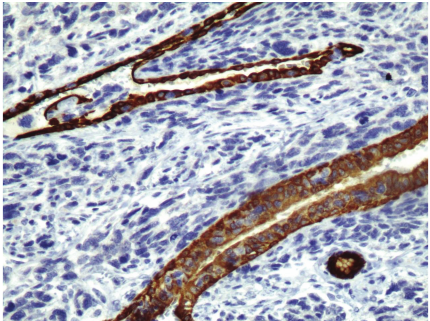
Figure 8: Scattered ovoid eosinophilic rhabdomyoblasts. H&E: × 200.